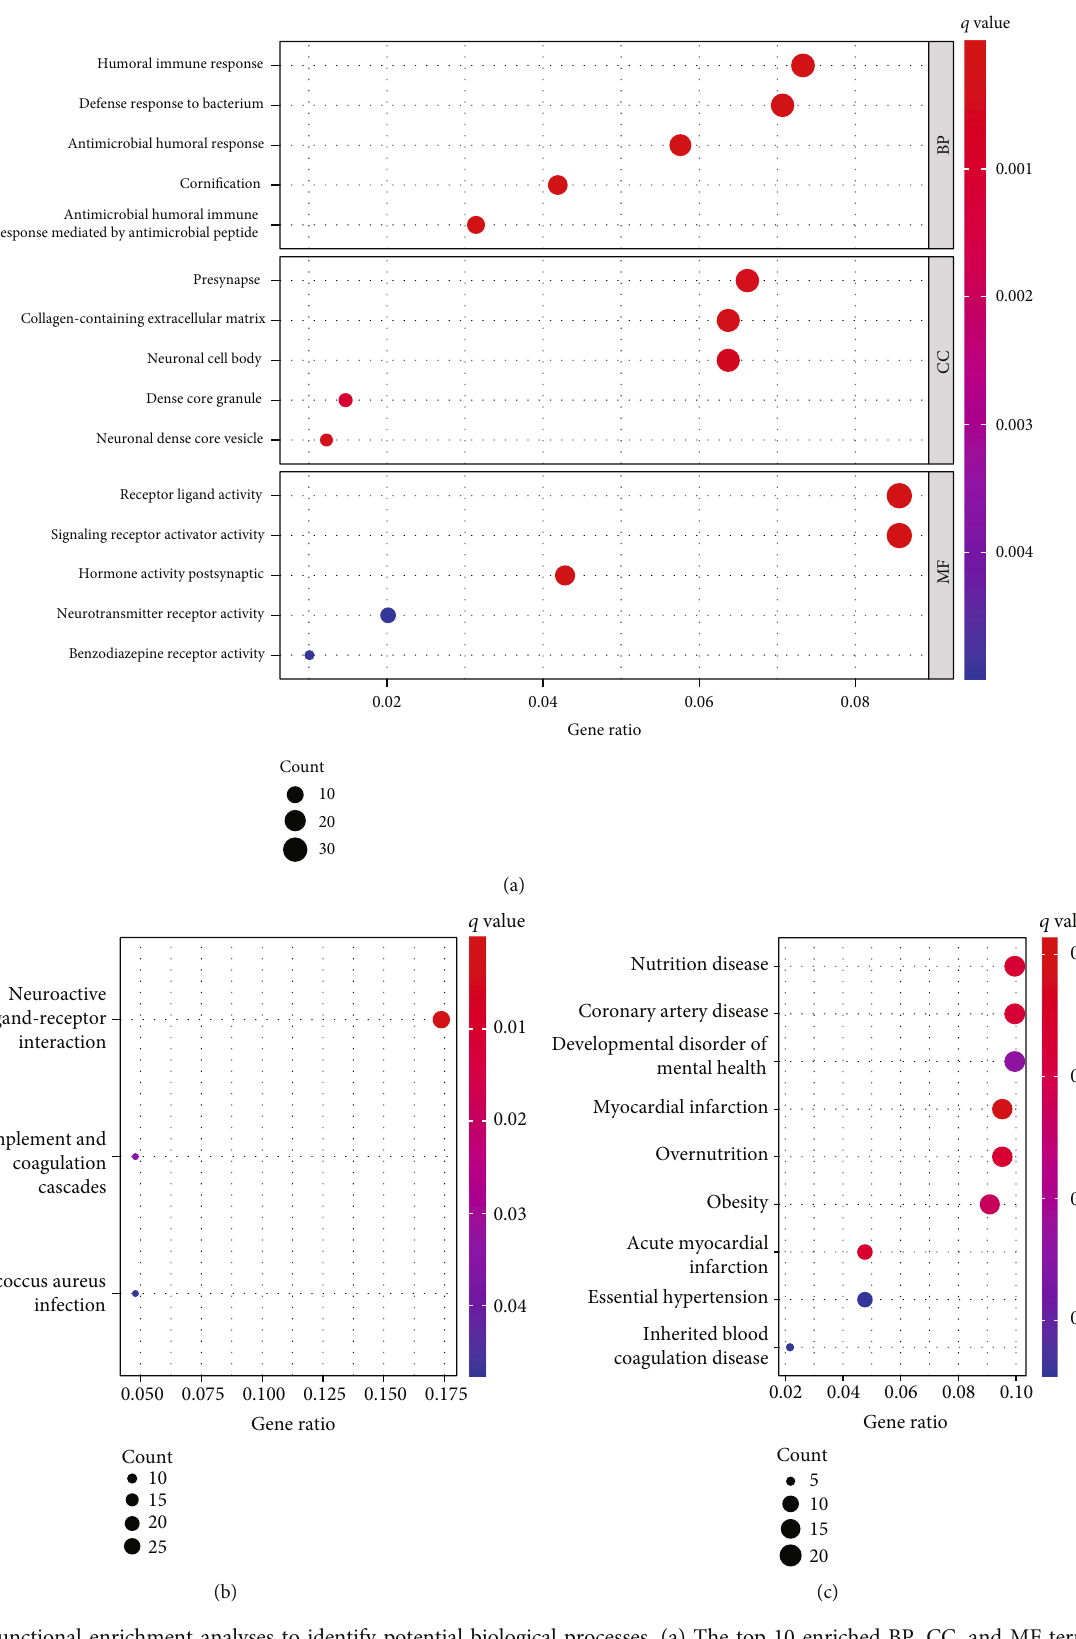
Figure 7: Functional enrichment analyses to identify potential biological processes. (a) The top 10 enriched BP, CC, and MF terms. (b) KEGG pathways. (c) Disease ontology enrichment